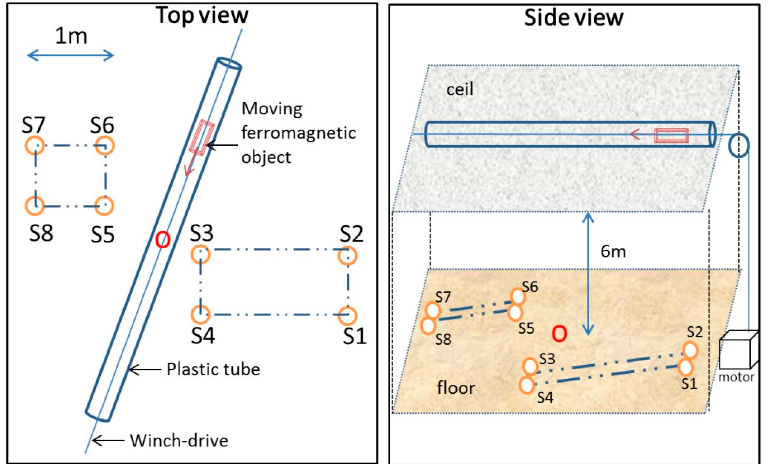
Figure 2. Top and side views of the experimental setup used in the experiment. Note the point O in red, which is the center of the searching box used in both GA and PSO.